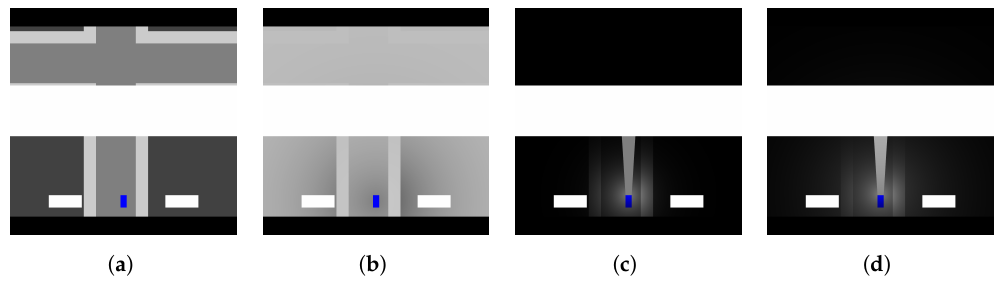
Figure 4. Sensing with masks for adverse driving condition contexts (blue rectangle representing a car and white rectangles representing masks). ( a ) Base sensing case, ( b ) Sensing in foggy weather, ( c ) Sensing night/low light, and ( d ) Sensing night with